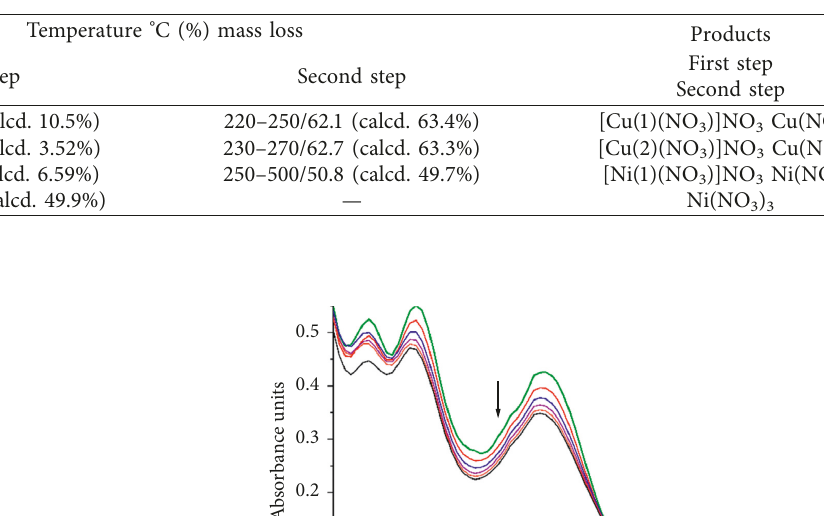
Figure 5: Electronic absorption spectra for (a) H with CT-DNA to concentrations of 10 μ mol (black) in